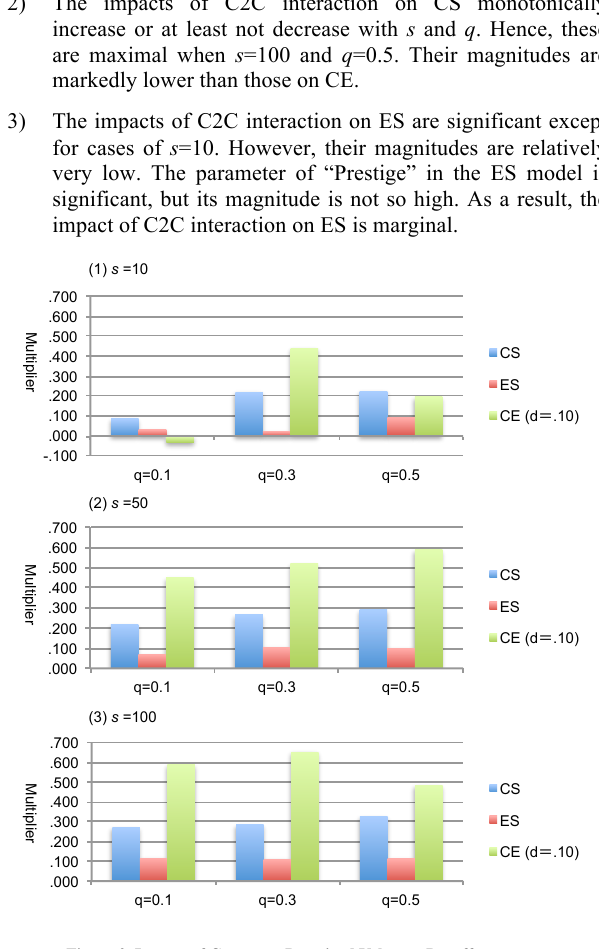
Figure 3. Impact of Customer-Perceived Value on Payoffs (Value of “Prestige” for